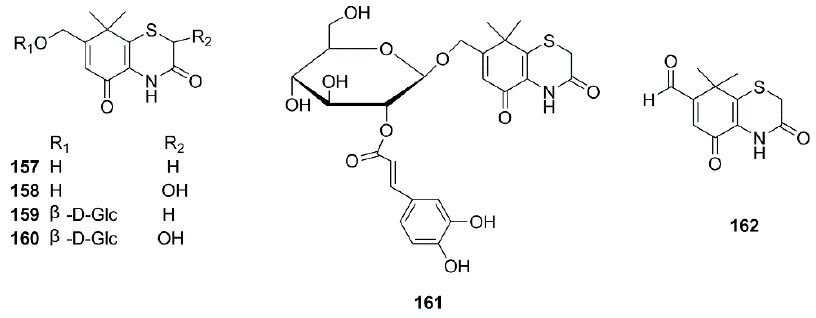
Figure 10. Chemical structures of the Thiazides in X. strumarium.